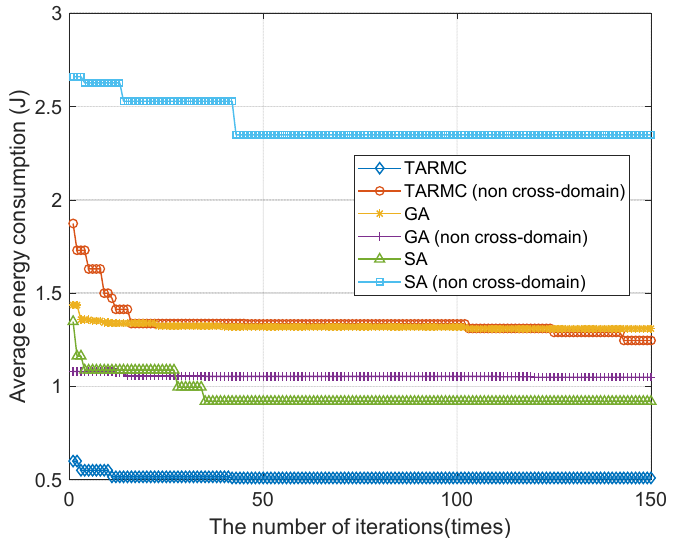
Figure 3. Average energy consumption of industrial intelligent terminals varies with resource allocation strategies.